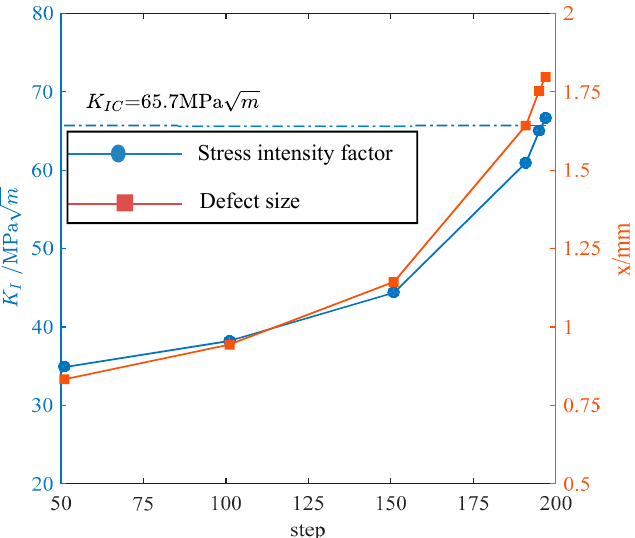
Figure 11. Damage evolution process and stress distribution of pre-corroded steel wire on a cross section. ( a ) step = 51; ( b ) step = 151; ( c ) step = 195.